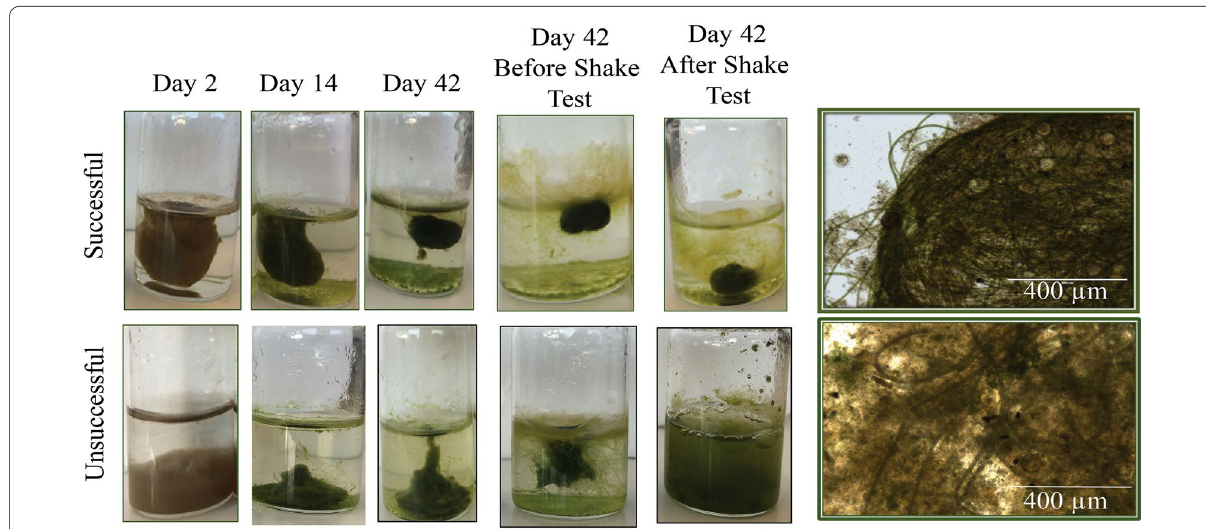
Fig. 2 Examples of biomass from successful ( top ) and unsuccessful ( bottom ) cultivation. The results include progression of granulation, before and after the shake test to verify granule rigidity and bright light microscopy (